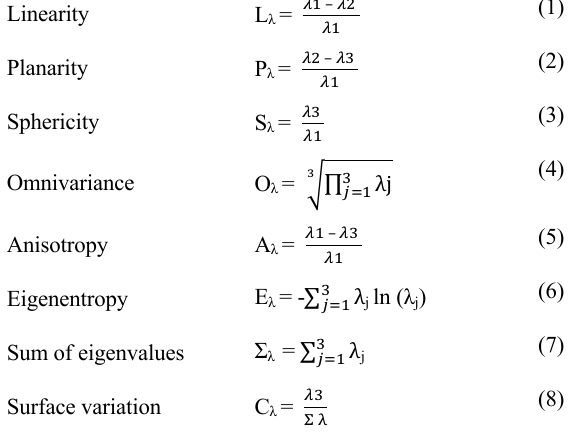
Table 1. Covariance